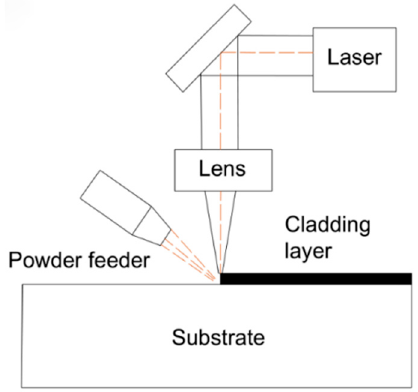
Figure 1. Laser cladding processing principle.